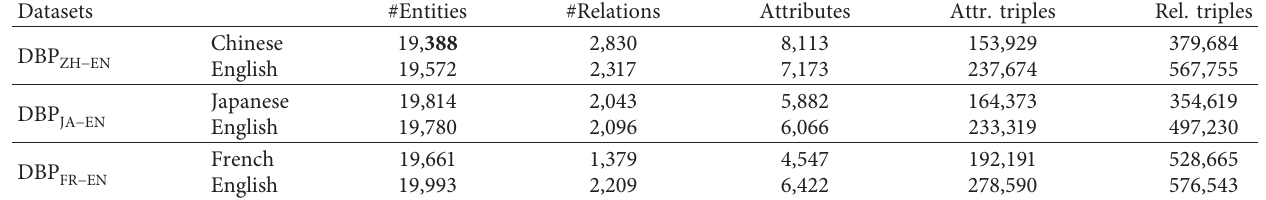
Table 1: The statistics of the datasets used in the experiment.